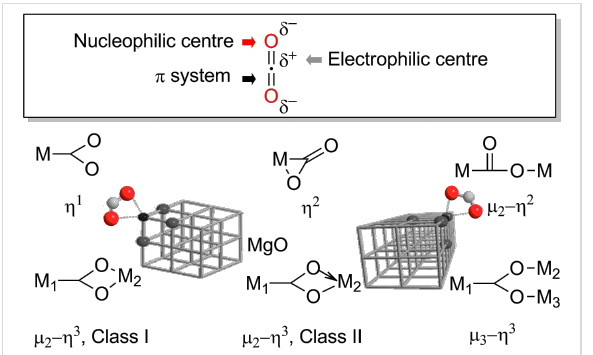
Figure 3: Threefold reactivity of carbon dioxide and examples for different activation modes for CO 2 involving metal centres in homoge- neous and heterogeneous catalysts